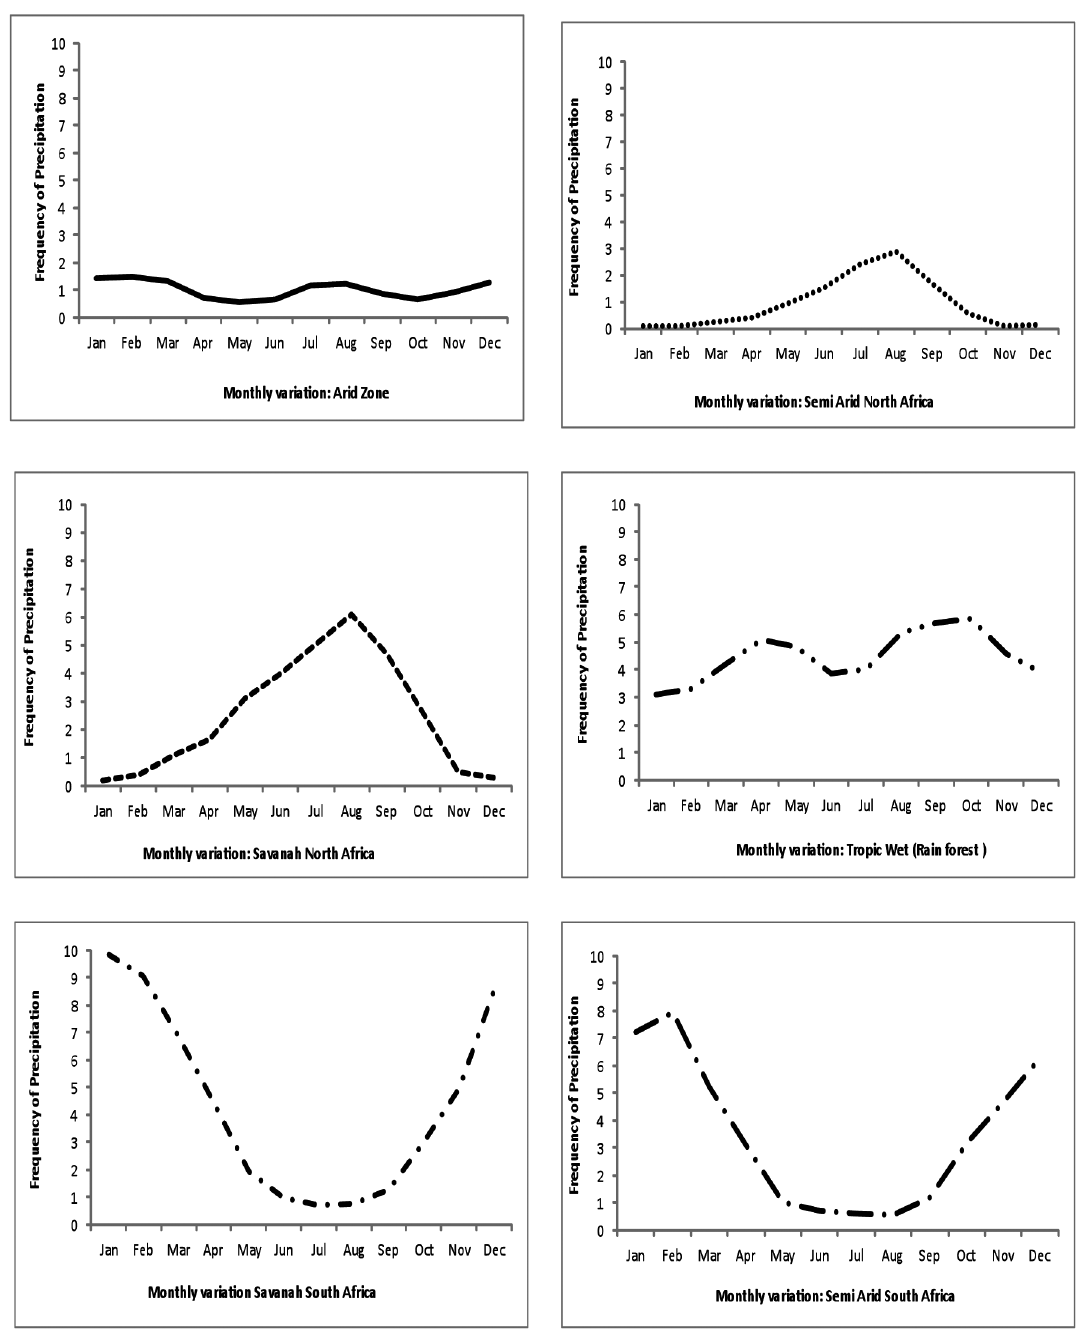
Figure 3. Monthly distribution of precipitation frequency in the six climatic